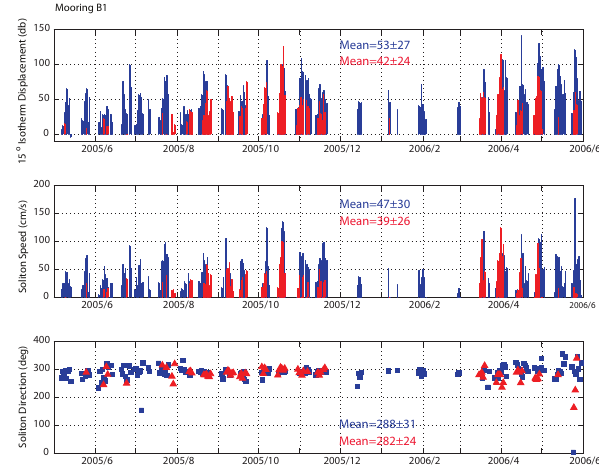
Fig. 6. A compendium of nonlinear wave characteristics as they passed mooring B1 from May 2005 to June 2006. The amplitudes based on the displacement of the 15 ◦ C isotherm (top panel), maximum upper layer orbital velocities as sensed by the ADCP (middle panel) and directions (bottom panel) are shown for the a- waves (blue) and the b-waves